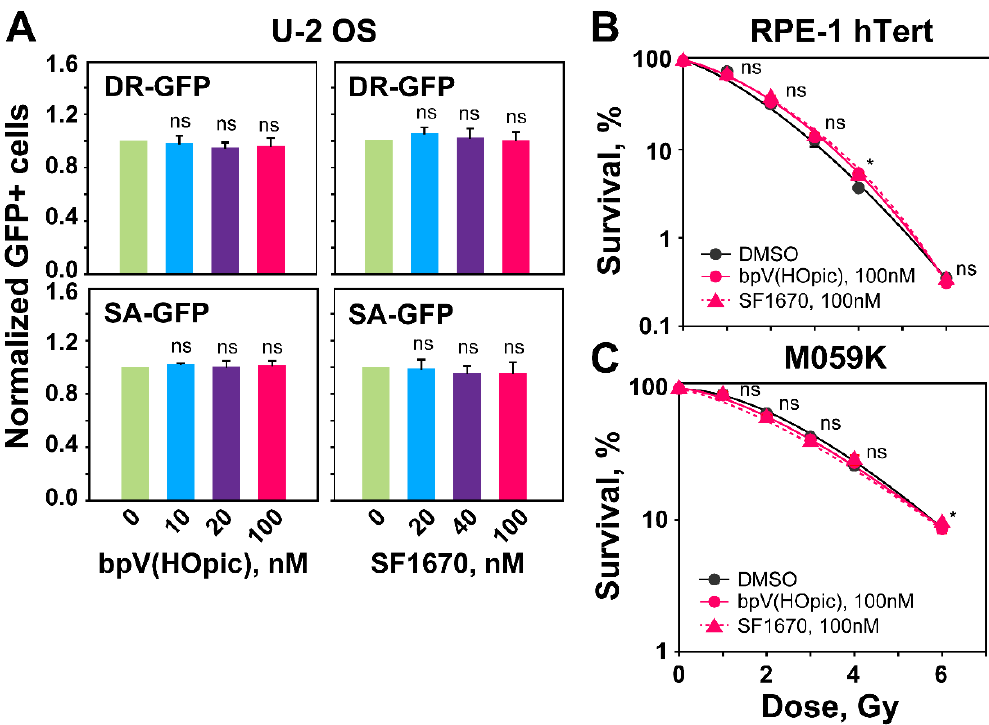
Figure 6. PTEN inhibition by bpV(HOpic) or SF1670 leaves unaffected the levels of HR or SSA determined by GFP-reporter assays. ( A ) DR-GFP and SA-GFP reporter U-2 OS cells treated with the indicated concentrations of PTEN inhibitors. GFP-positive cells (GFP+) are measured 48 h after transfection with I-SceI expression plasmid. ( B ) Clonogenic survival assays with RPE-1 hTert cells treated with the indicated concentrations of PTENi. ( C ) Same as panel ( B ), but for M059K cells. Data represent the means ± SD from three independent experiments. ANOVA analysis with Tukey HSD post hoc test is used to calculate the statistical significance for the data plotted in Figure 6A, while the significance level in Figure 6B,C is calculated using the two-tailed Student´s t -test: ns (not significant), * p < 0.05.